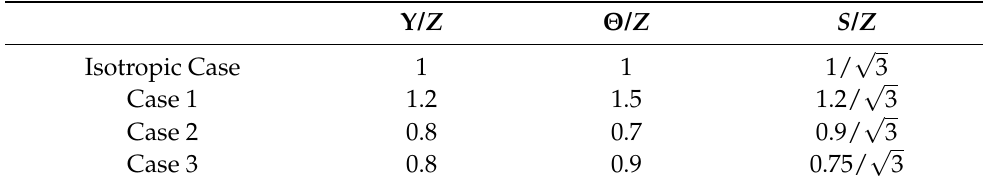
Table 2. Yield stresses chosen to illustrate the effect of plastic anisotropy on the interpretation of the friction